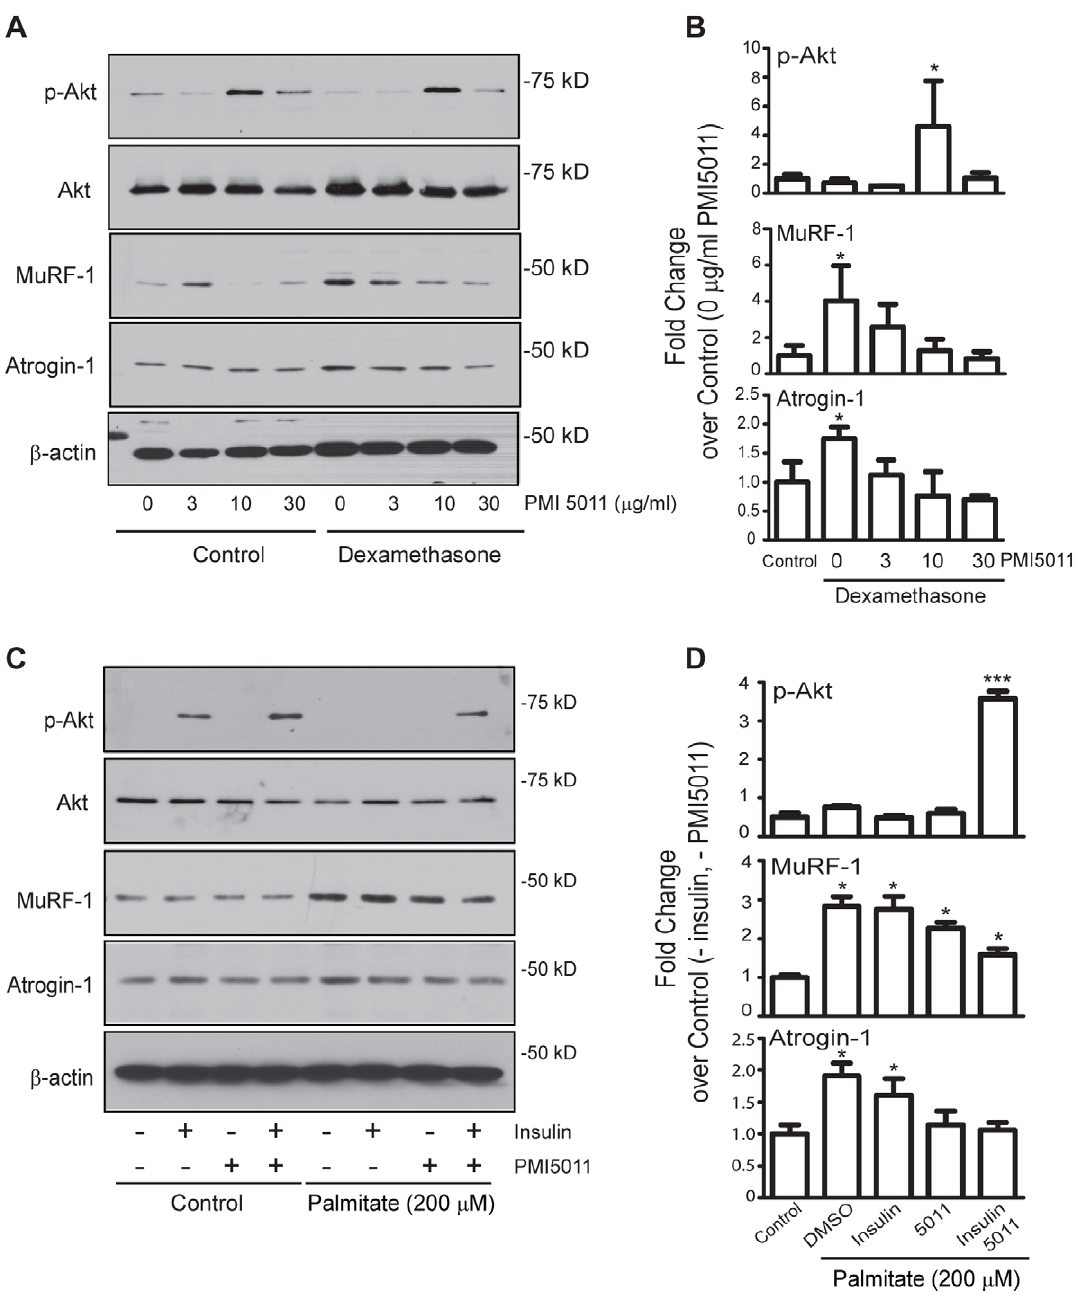
Figure 2. PMI5011 regulates expression of Atrogin-1 and MuRF-1 in two models of insulin resistance invitro . (A) C2C12 myotubes were incubated in the absence (DMSO) or presence of PMI5011 at the indicated concentrations for 16 hours prior to the addition of dexamethasone (1 m M). Twenty-four hour after adding dexamethasone, whole cell extracts were harvested and subjected to SDS-PAGE followed by western blot analysis to determine phospho-Akt, total Akt, Atrogin-1 and MuRF-1 protein levels. b -actin is included as a loading control. (B) The fold change over control for phospho-Akt, MuRF-1 and Atrogin-1 protein levels was analyzed from three independent experiments. * p , 0.05 compared to control. (C) The C2C12 myotubes were incubated in the absence (DMSO) or PMI5011 (10 m g/ml) for 16 hours prior to adding palmitic acid (200 m M) as indicated. Twenty-four hours later, the cells were serum-deprived for 4 hours prior to insulin-stimulation (100 nM insulin) for 2 hours. Whole cell extracts were harvested and subjected to SDS-PAGE followed by western blot analysis of phospho-Akt, total Akt, Atrogin-1 and MuRF-1 protein levels. (D) The fold change over control for phospho-Akt, MuRF-1 and Atrogin-1 protein levels was analyzed from three independent experiments. * p , 0.05,*** p , 0.001 compared to control. Millipore (Billerica, MA). Briefly, the cell lysates were harvested in the lysis buffer to maintain 26S proteasome activity. Proteasome 50 mM Tris-Cl, pH 7.4 with 25 mM KCl, 2 mM MgCl 2 , 0.1% activity was measured by incubating 20 m g of protein per sample Triton X-100, 2 mM ATP, 2 mM PMSF. MgATP is included in of each lysate at 37 u C for 60 min. Chymotrypsin-like activity was